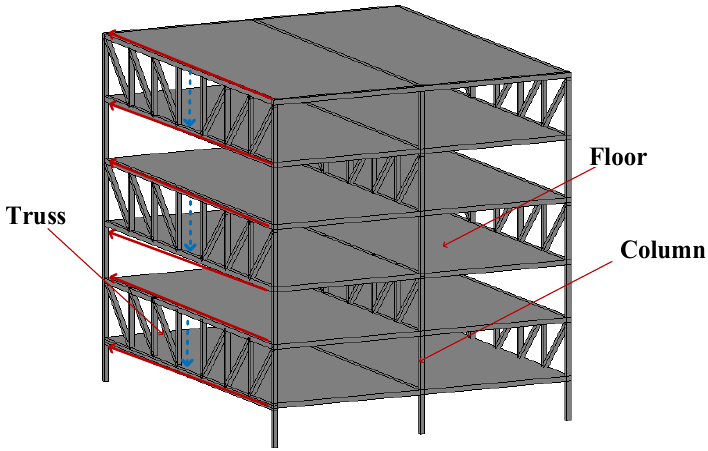
Figure 1. Horizontal force transmission path of a staggered truss steel framing